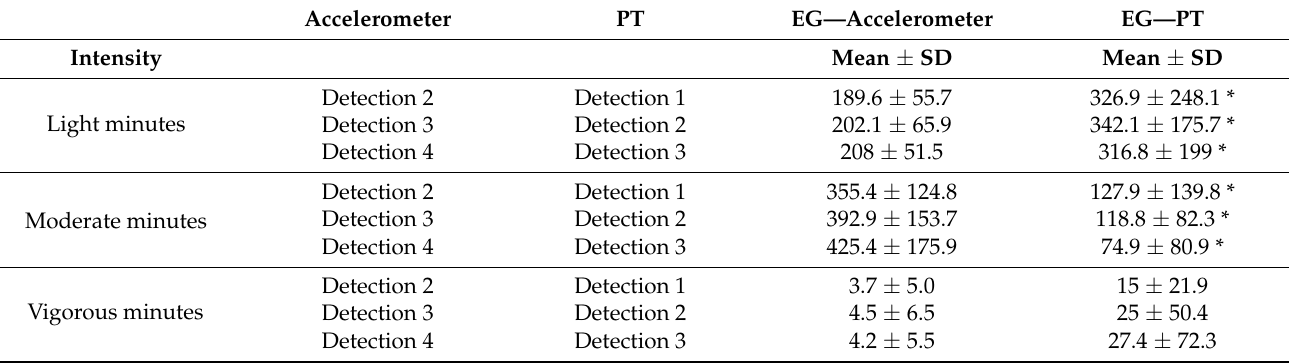
Table 5. The outcomes of the App UP1–0—Pocket Trainer used in the intervention.